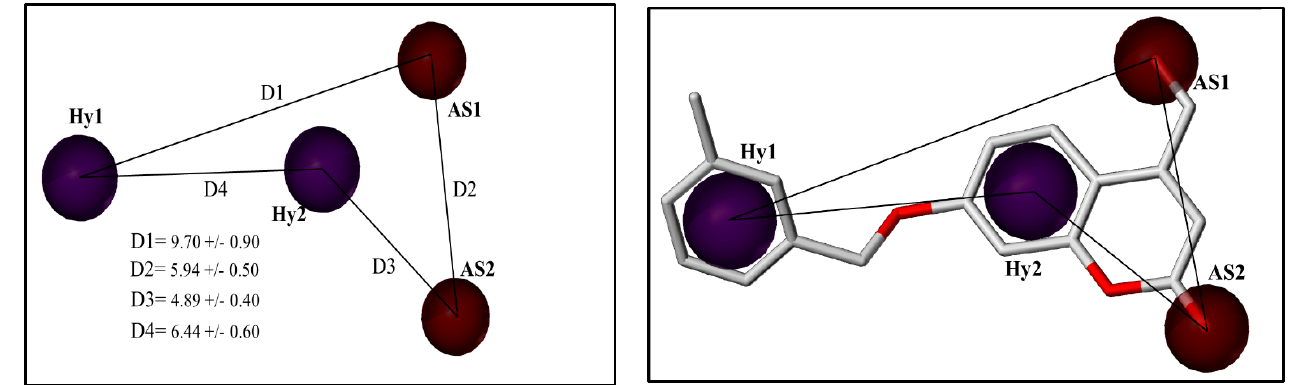
Figure 4. The image shows the pharmacological models generated with the PHASE module. This model yielded 875776 hits from the ZINC database after virtual screening.